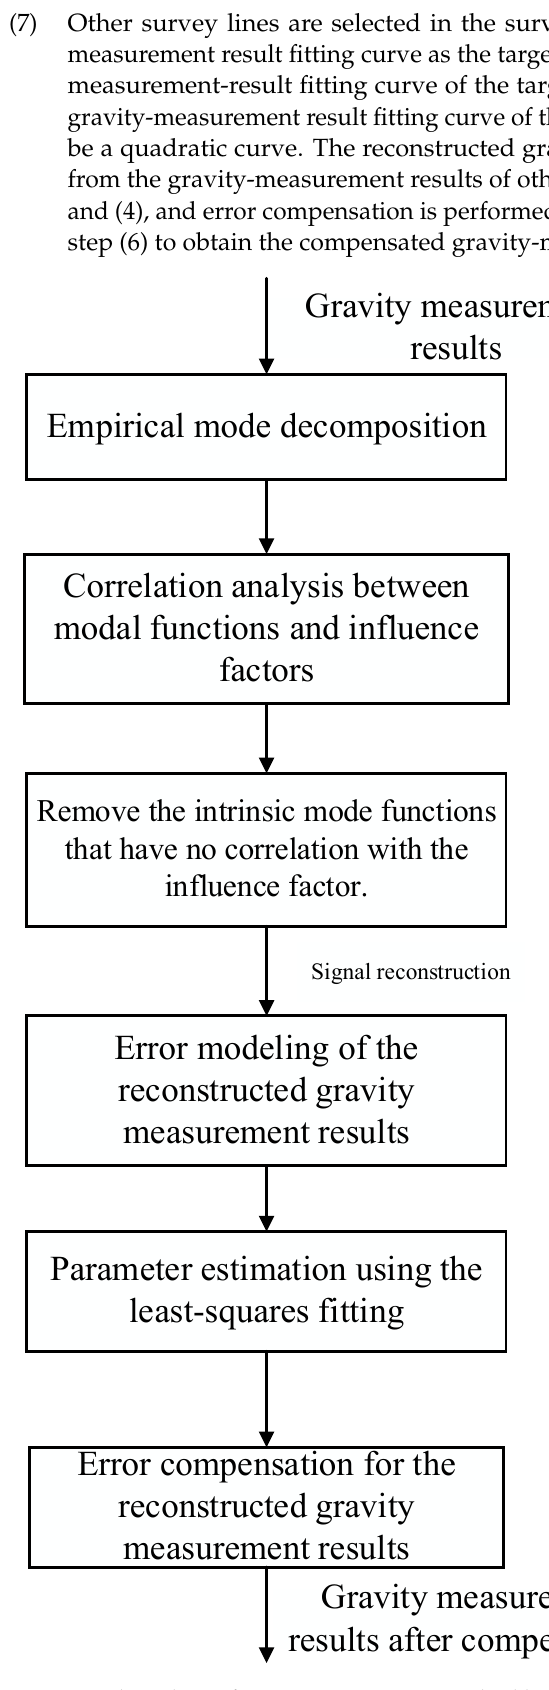
Figure 1. Flow chart of error compensation method based on correlation analysis. Each model parameter in Formula (2) is estimated by the least-squares fitting method to obtain the specific form of the error equation. According to the error model, recon- structed gravity-measurement results are error-compensated to obtain compensated gravity-measurement results. The error compensation equation is shown in Formula (3):